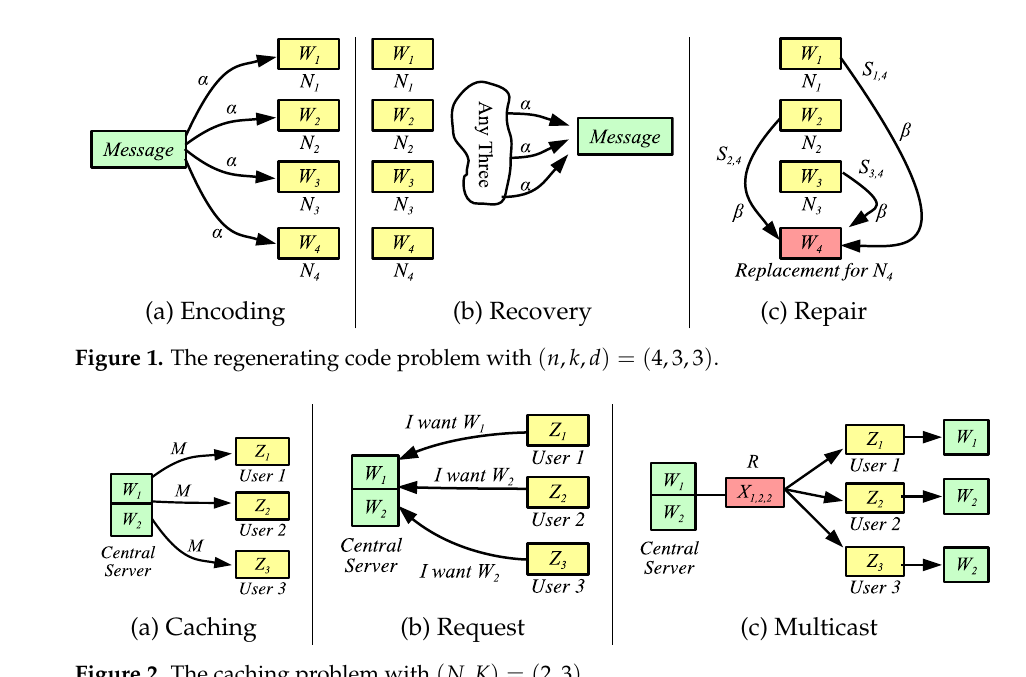
Figure 2. The caching problem with ( N , K ) = ( 2,3 )